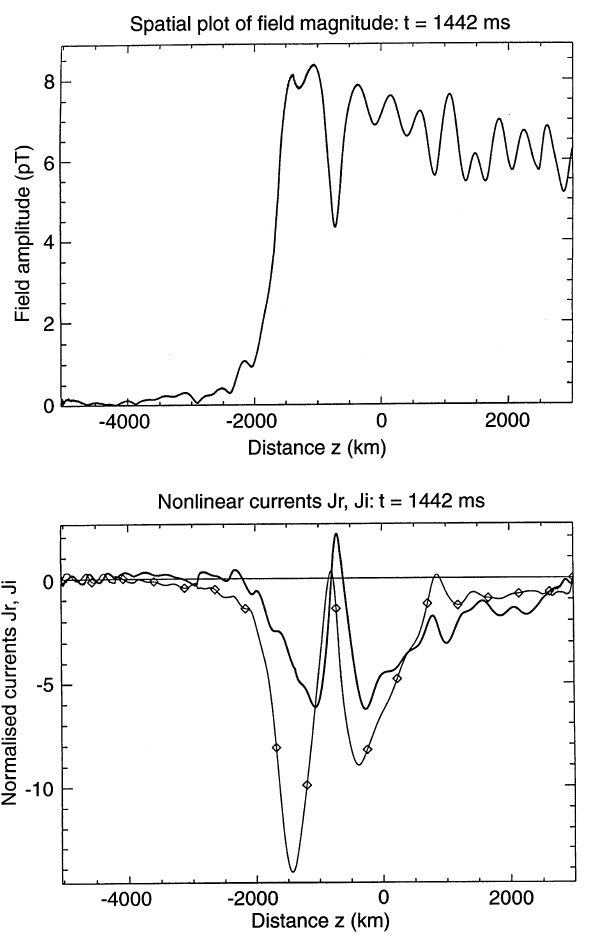
Fig. 6. Case A. Plots of wave field amplitude (pT), in phase nonlinear current ( J ) and out of phase current ( J ) as functions of z at r i t = 1.442 s. The heavy line is J , the light line J . This represents a r i snapshot of the structure of a typical VLF generation region for a rising